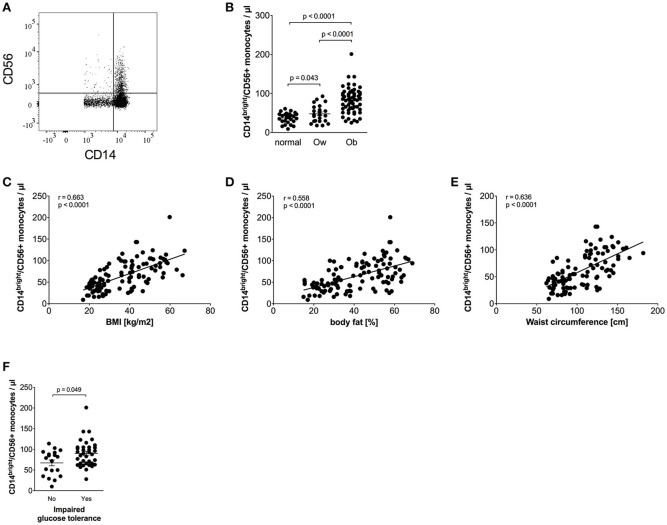
Quantification of CD56+ monocytes of normal, overweight, and obese individuals. (A) Representative dot plot of CD14 and CD56 expression on monocytes. (B) Absolute numbers of CD56+ monocytes of normal (n = 27), overweight (ow, n = 23), and obese (ob, n = 60) individuals. Scatter plots show mean ± SEM. (C–E) Correlation of CD56+ monocyte numbers with BMI (C, n = 110), body fat (D, n = 108), and waist circumference (E, n = 101). (F) Absolute numbers of CD56+ monocytes of obese individuals with (n = 36) and without (n = 19) impaired glucose tolerance. Scatter plots show mean ± SEM.